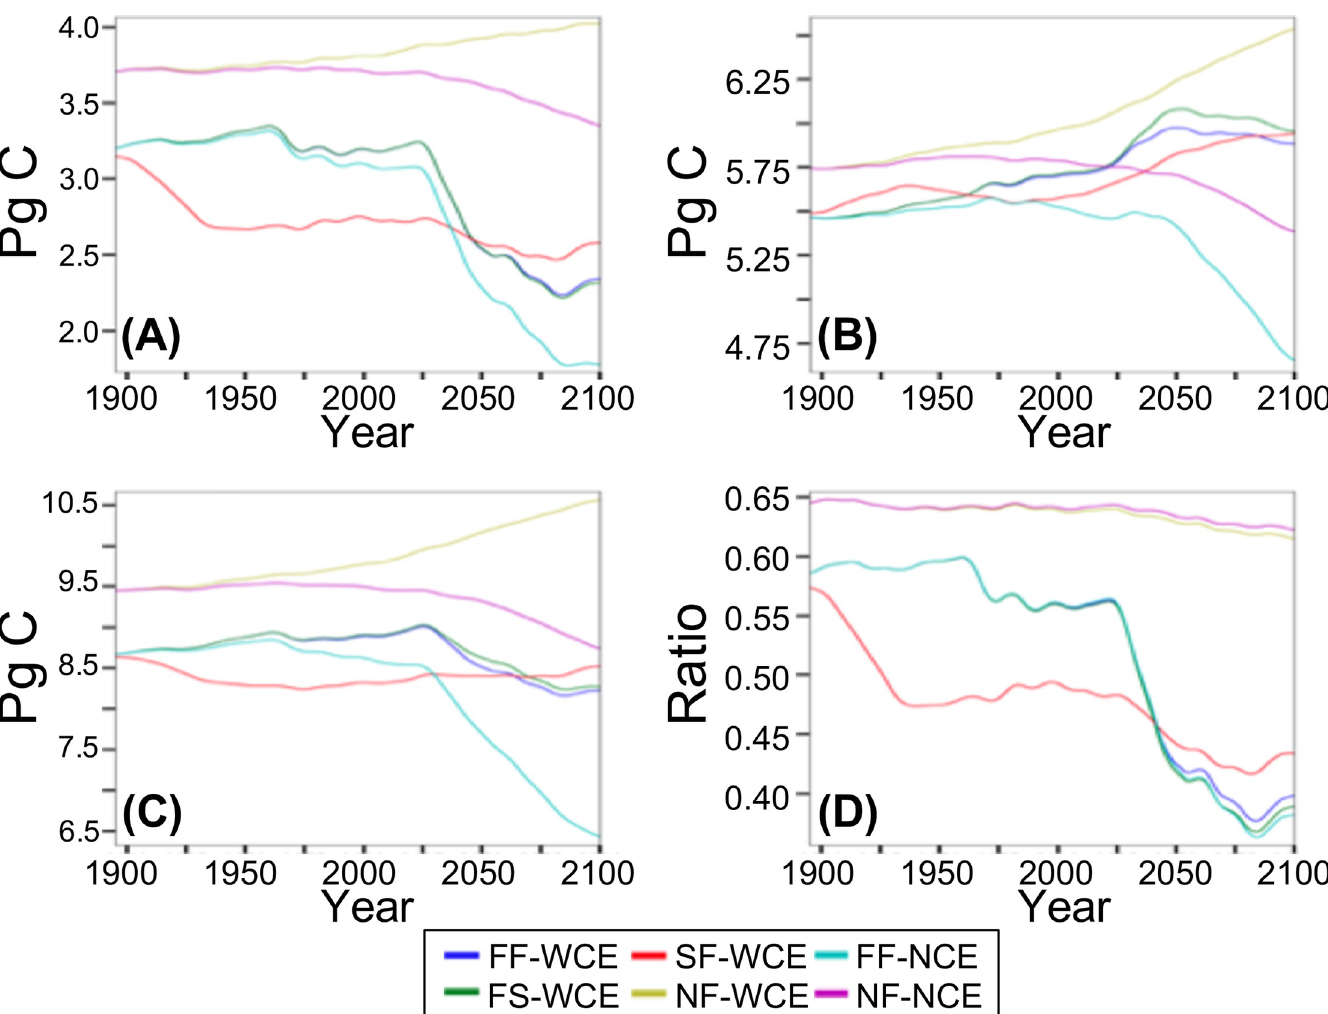
Fig 9. Carbon pools and live/dead ratios. (A) live C, (B) dead C, (C) ecosystem C, and (D) ratio of live C to dead C. (FF-WCE: full fire, with CO 2 fertilization effect; FS-WCE: with fire suppression, with